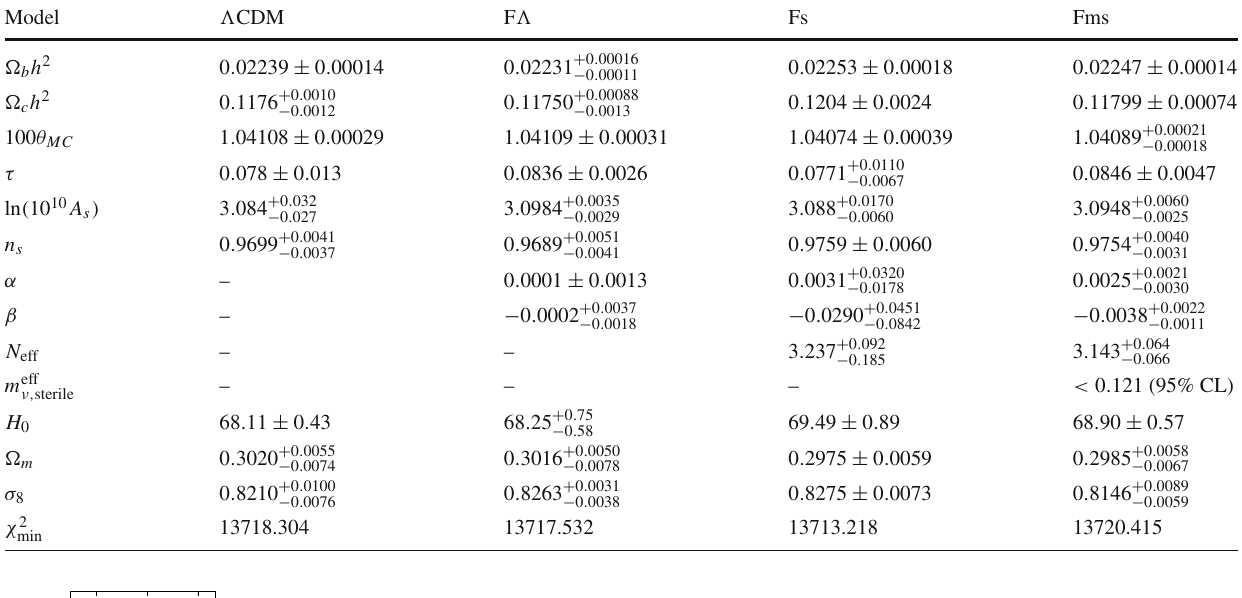
Table1 Themarginalizedconstrainingresultsofdifferentparametersinthe (cid:5) CDM,F (cid:5) ,Fs,andFmsmodelsusingthedatacombinationCBSLCH, respectively. Note that we quote the 95% limits for the parameters which cannot be well constrained